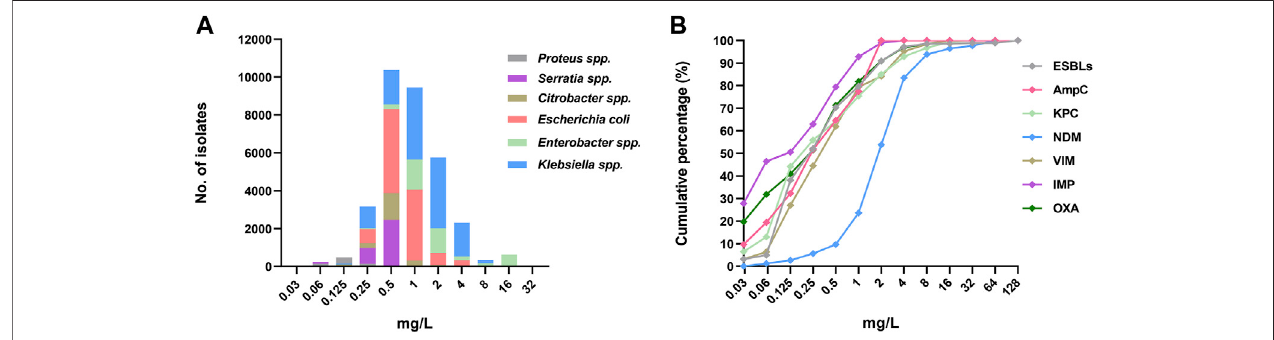
FIGURE4| The ce fi derocolMIC pro fi le ofdifferent species of Enterobacterales , (A) , theMIC 90 distribution; (B) ,the cumulative curves ofMICsof1264isolates(n= 15) harboring different β -lactamase.